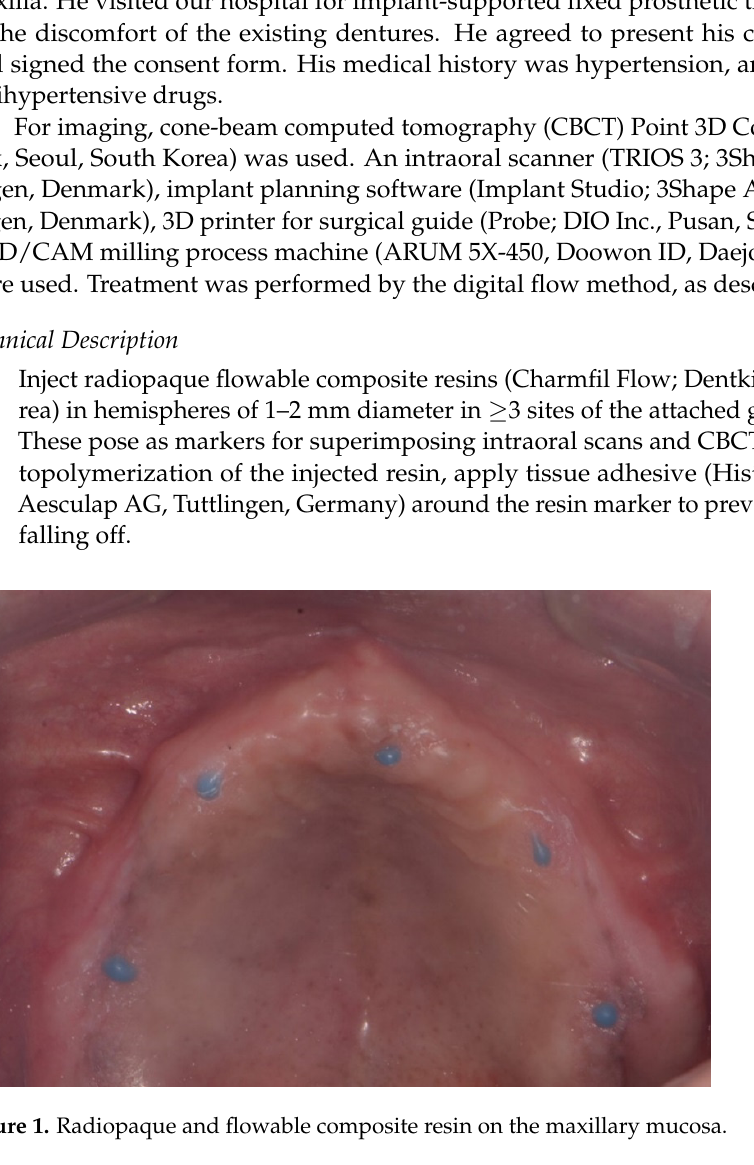
Figure 2. Scan the impression surface of the patient’s prostheses. The upper and lower occlusal re- lationships were scanned.